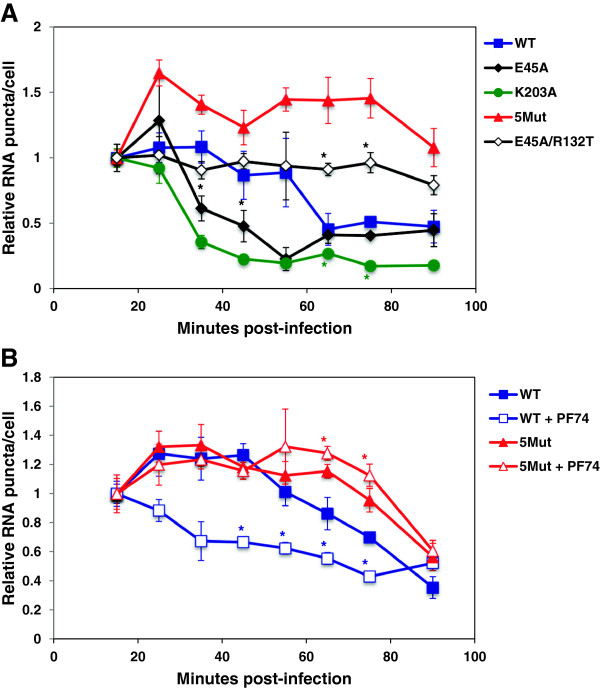
Viral RNA staining is altered by mutations that affect capsid stability. TZM-bl cells were infected with (A) EU-labeled WT, E45A, K203A, 5Mut, and E45A/R132T HIV-1; or (B) EU-labeled WT and 5Mut HIV-1 in the presence and absence of 10 μM PF74. 0.6 - 4.4 vRNA puncta were detected per cell. Data represent the mean ± SEM of at least 4 fields and the first time point was normalized to 1. Asterisks denote statistically significant p values (p < 0.05) between WT and each mutant or with or without PF74 treatment at each time point. The graphs are representative of 2 independent experiments.